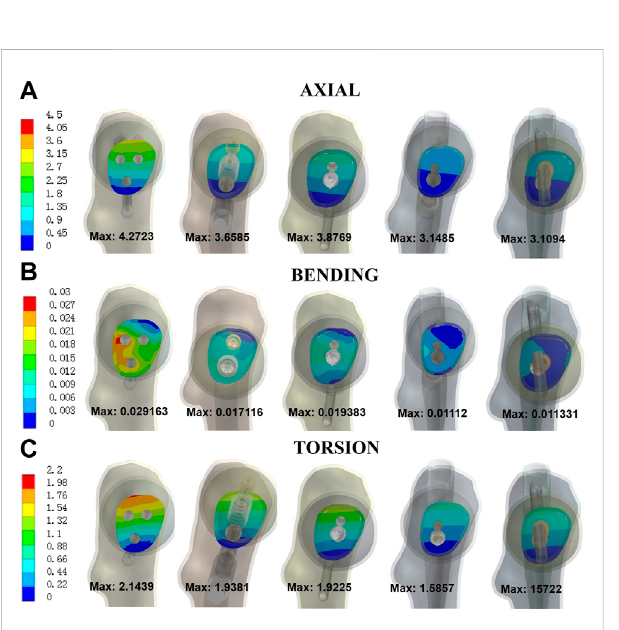
FIGURE 5 Von Mises stress at implants for three different loads. (A) axial; (B) bending; (C)